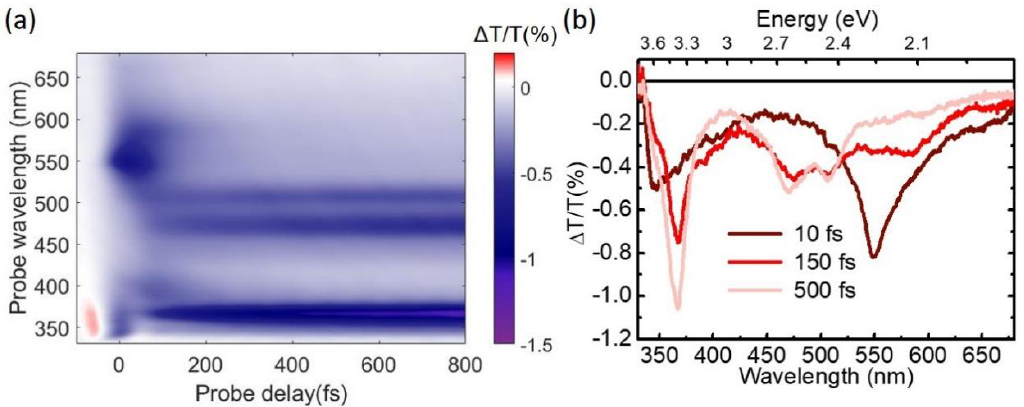
Figure 9. ( a ) TA map of pyrene as a function of probe wavelength and delay following excitation at 270 nm; ( b ) TA spectra at different pump-probe delays.